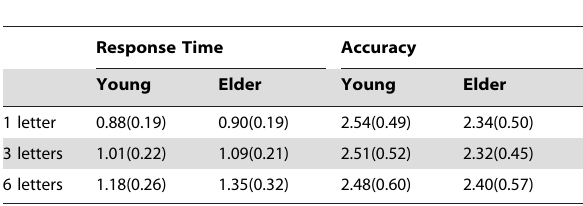
Table 1. Mean (standard deviation) response times and accuracies (d L